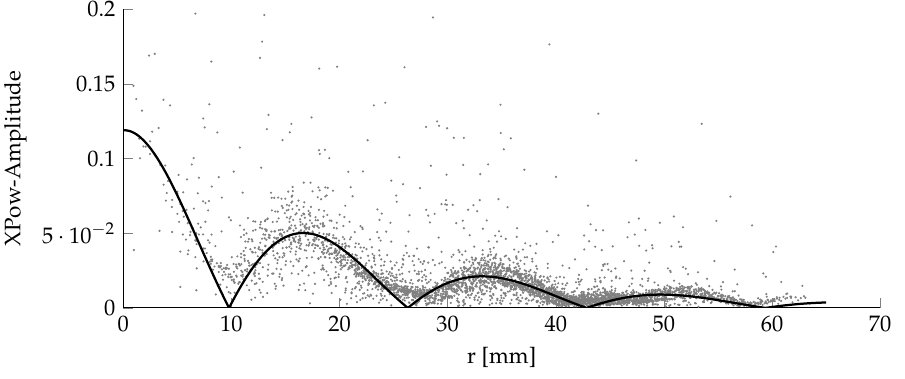
Figure 10. Amplitude approximation of the equation to measured values.